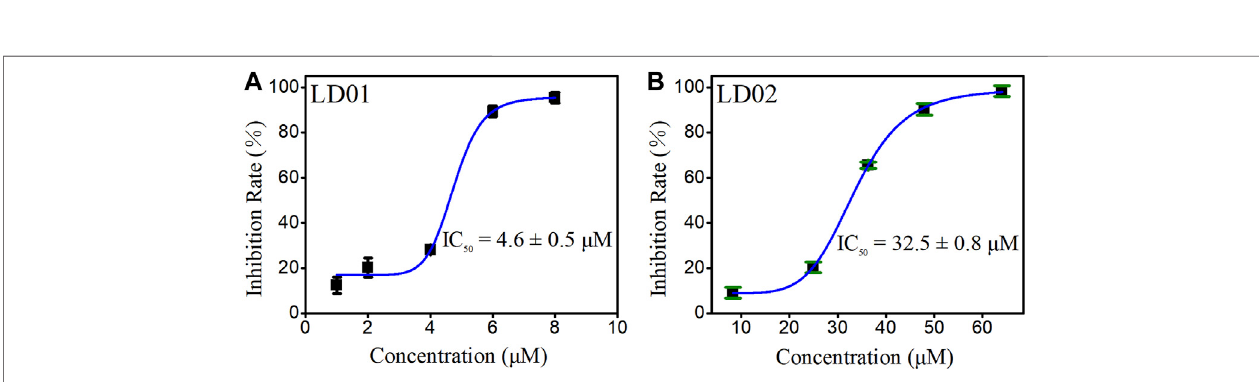
Frontiers in Chemistry |